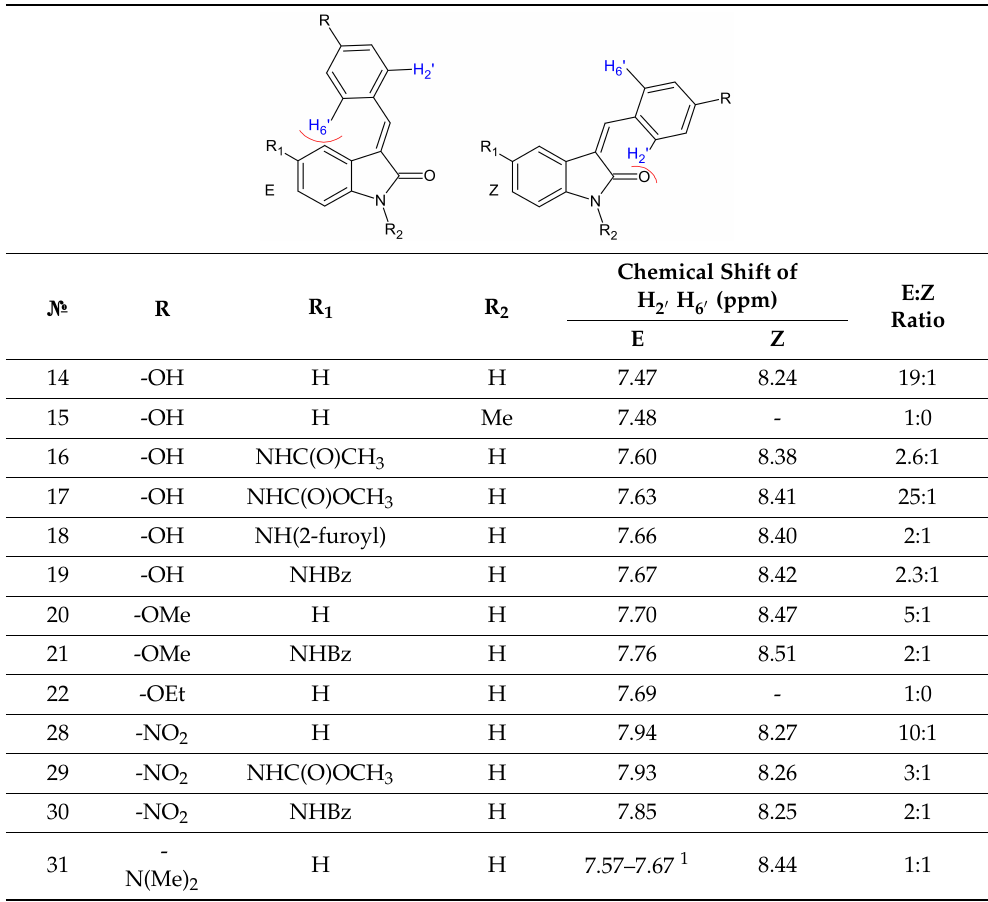
Table 1. Preferred configurations of 4 (cid:48) -substituted benzylidene-2-oxindoles and corresponding characteristic chemical